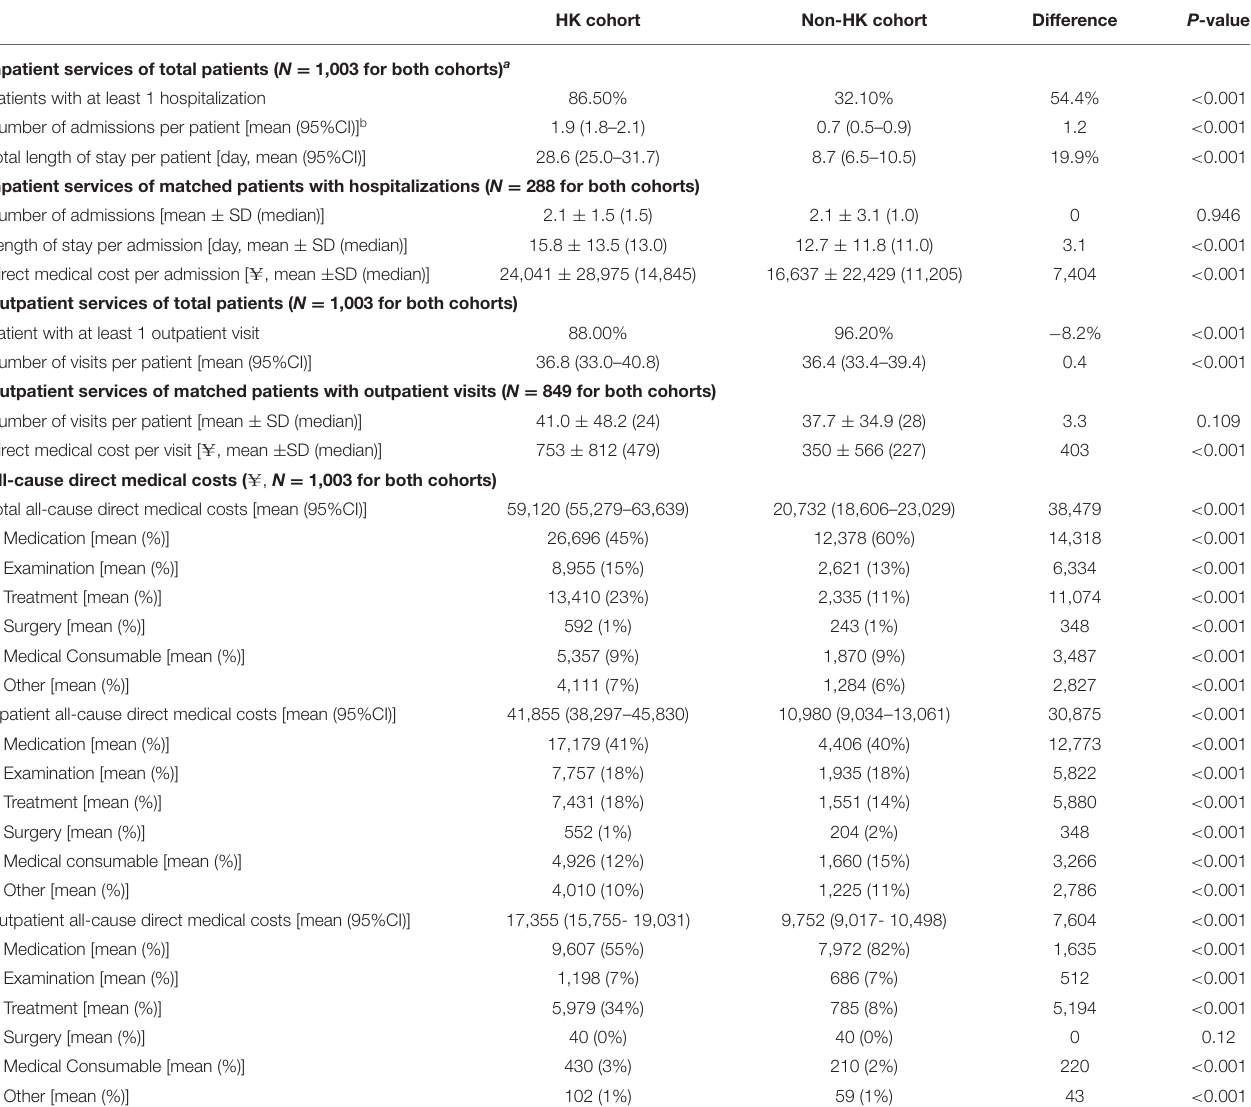
TABLE 3 | The all-cause healthcare resource utilization and associated costs during the 12-month follow-up period. HK cohort Non-HK cohort Difference P- value Inpatient services of total patients ( N = 1,003 for both cohorts) a Patients with at least 1 hospitalization